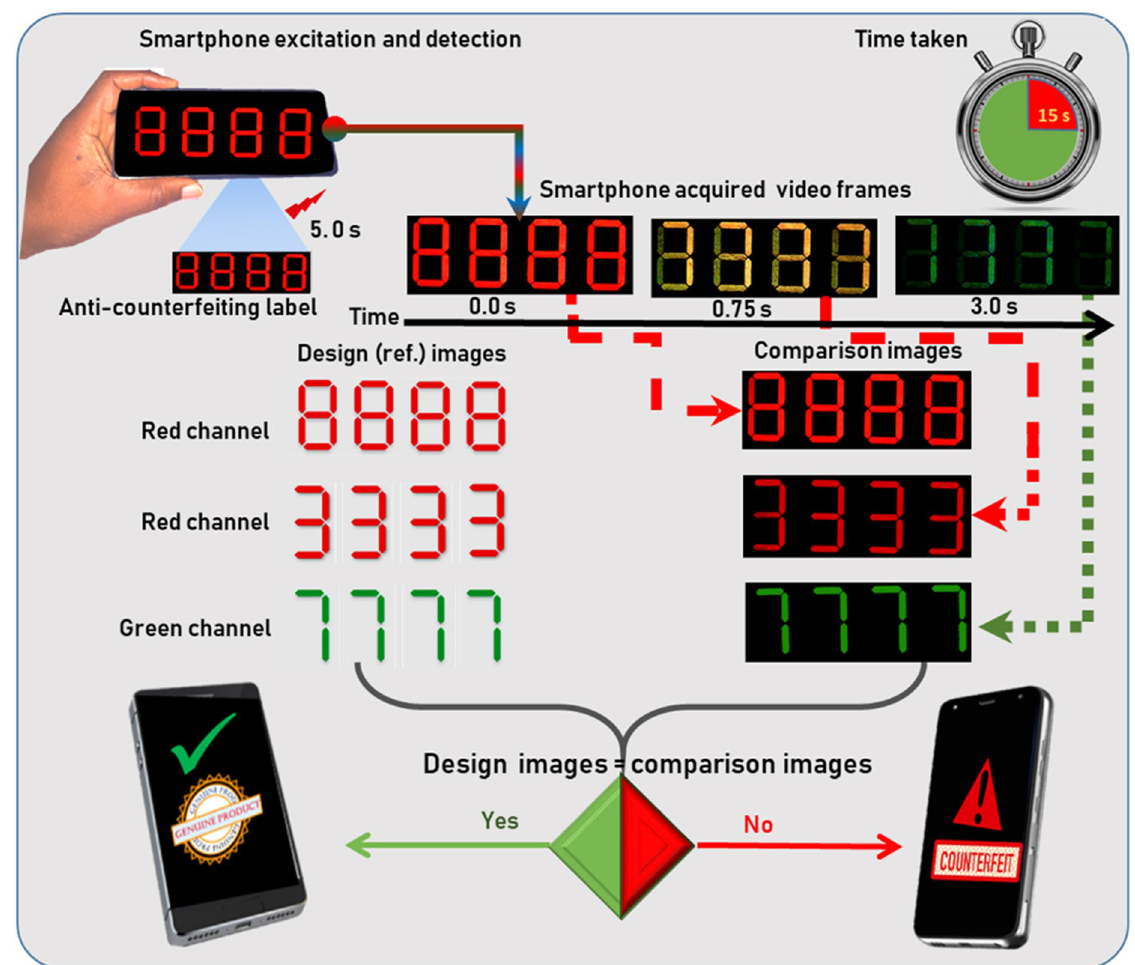
Figure 1. Schematic illustration of smartphone-based authentication of dynamic and color tunable anti- counterfeiting labels. The label is first irradiated with the smartphone-flashlight for 5 s and then the persistent emission is video-recorded with the smartphone’s camera. The acquired raw video is then split at into the red and green channel and the frames at various timestamps (for red 0.0 and 0.75 s and for green 3.0 s) are compared to the intended design images. If the images of the split frames match with the designed image the product is genuine, else counterfeit. The total time taken is less than 15 the authors’ previous work 26 . Finally, to achieve a shift in color in the dynamic pattern, a blend of two or more phosphors with different emission spectra is required. The smartphone-only authentication process would then proceed as illustrated in Fig. 1. The process starts with the smartphone video-recording turned on, followed by a 5 s flashlight illumination and continuous capture of the emission for a further 10 s. In this case, a seven-segment display is targeted that should have the following characteristics. During illumination with the smartphone flashlight, a ‘8 8 8 8’ should be observed when the red channel of a still frame of the smartphone video is considered. At 0.3 s after the flashlight is extinguished a ‘3 3 3 3’ should be observed in the red channel of the still frame extracted from the video. Finally, 3 s after excita- tion ‘7 7 7 7’ should be observed in the green channel. If analysis of stills extracted from the smartphone video